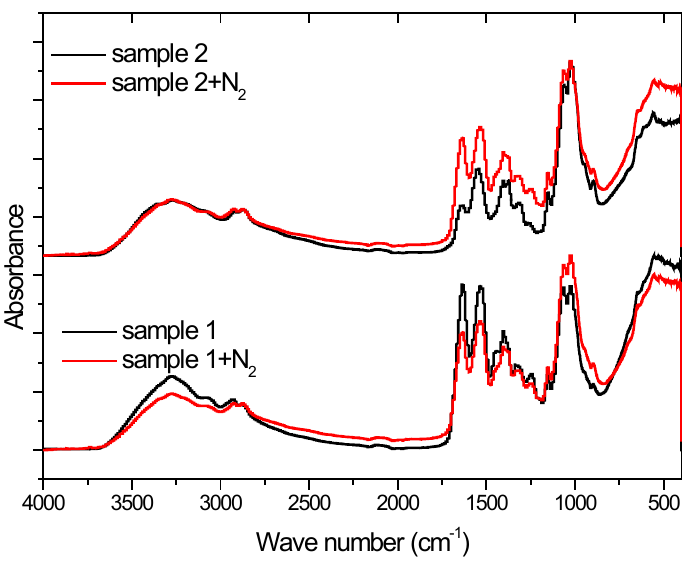
Figure 2. FTIR‒ATR spectra of chitosan foils. Figure 2. FTIR-ATR spectra of chitosan